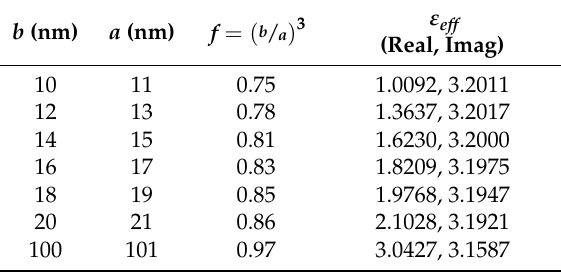
Table 2. The effective permittivity of an Fe 3 O 4 @Au core-shell for variations of core radius. b (nm)